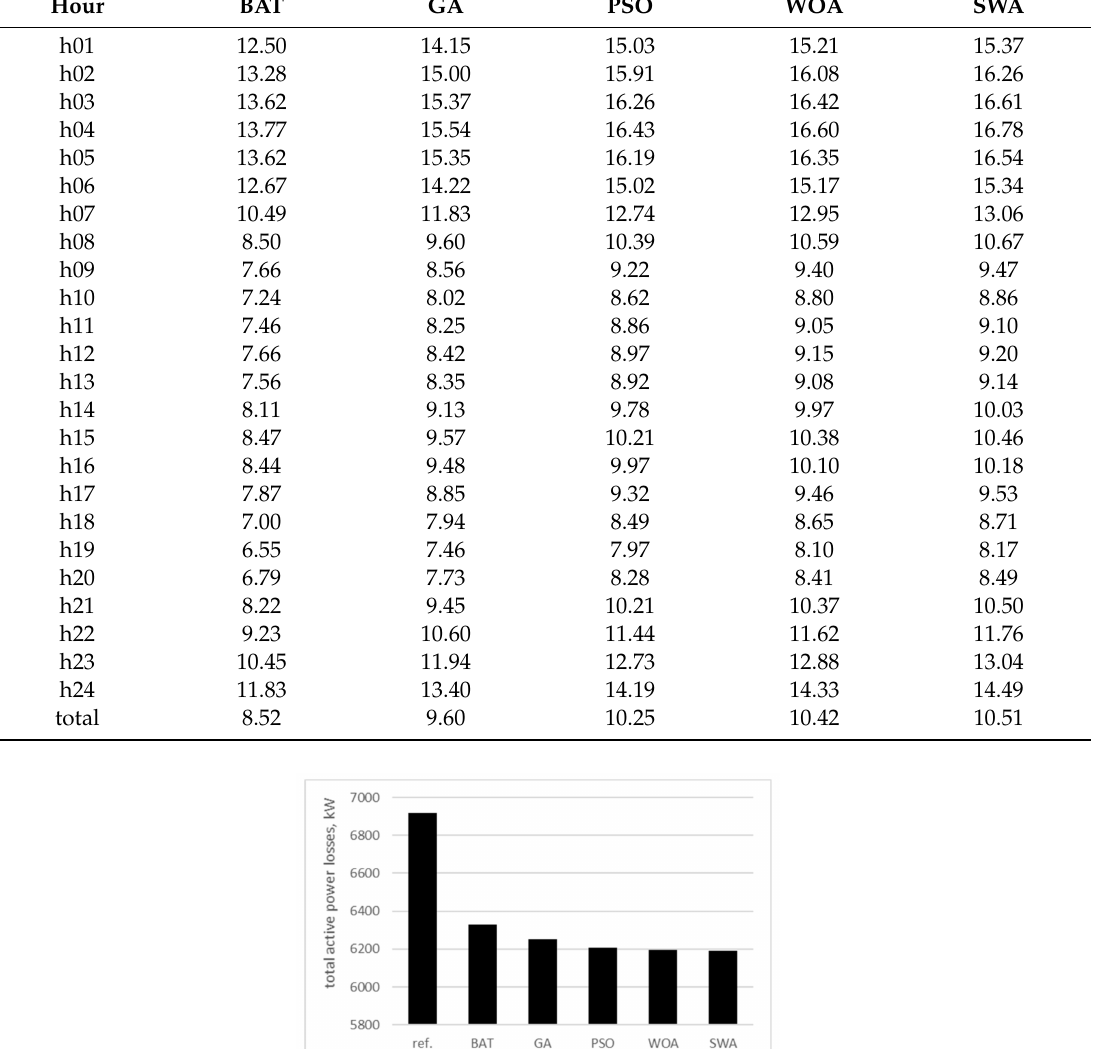
Table 9. Hourly and total power loss reduction in the IEEE 33-bus system, in %, for each algorithm.